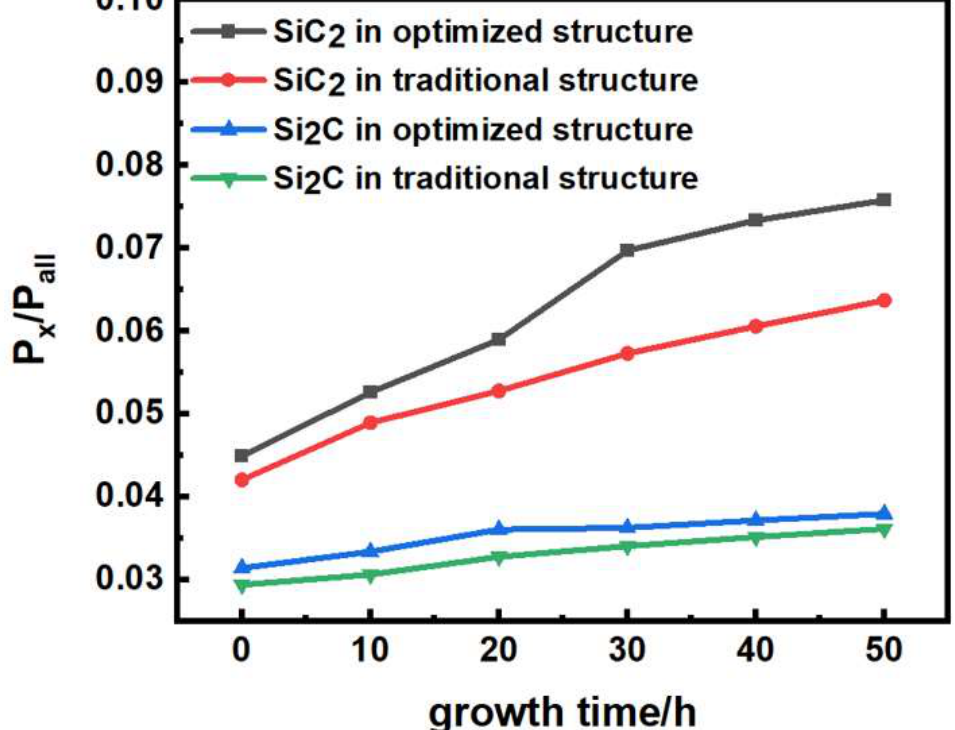
Figure 5. The pressure fraction of SiC 2 and Si 2 C gas in different structures. In order to explore the influence of temperature and powder evolution on the gas transport, we investigated the gas transport process in different structures. Figure 6a shows the flow path of the sublimated SiC (Si, Si 2 C, SiC 2 ) during the growth process. In the traditional structure, the vapor in the powder flowed out close to the crucible wall. Part of the vapor reached the surface of the seed crystal. The rest flowed in the reverse direction. We believe that the reverse transport was caused by the evolution difference between the surface powder and the bottom powder. The low temperature of the powder on the surface led to low vapor saturation, and the vapor transport from the high temperature on both sides recrystallized on the surface, forming the reverse transport. The reverse transport not only caused gas turbulence in the growth area but also prevented internal gas from flowing out of the central area. Yang [20] studied the carbon inclusions in PVT-grown SiC single crystal. They pointed out that carbon inclusions were induced by the graphitization of raw materials. Our current results show that vapor could only be transported from the highly graphitized powder because of the reverse transport, which undoubtedly increased the possibility of carbon